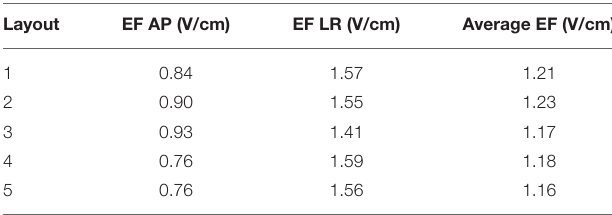
TABLE 2 | Average EF intensity in the tumor when 900mA were injected into the AP (second column) and into the LR (third column) pairs.